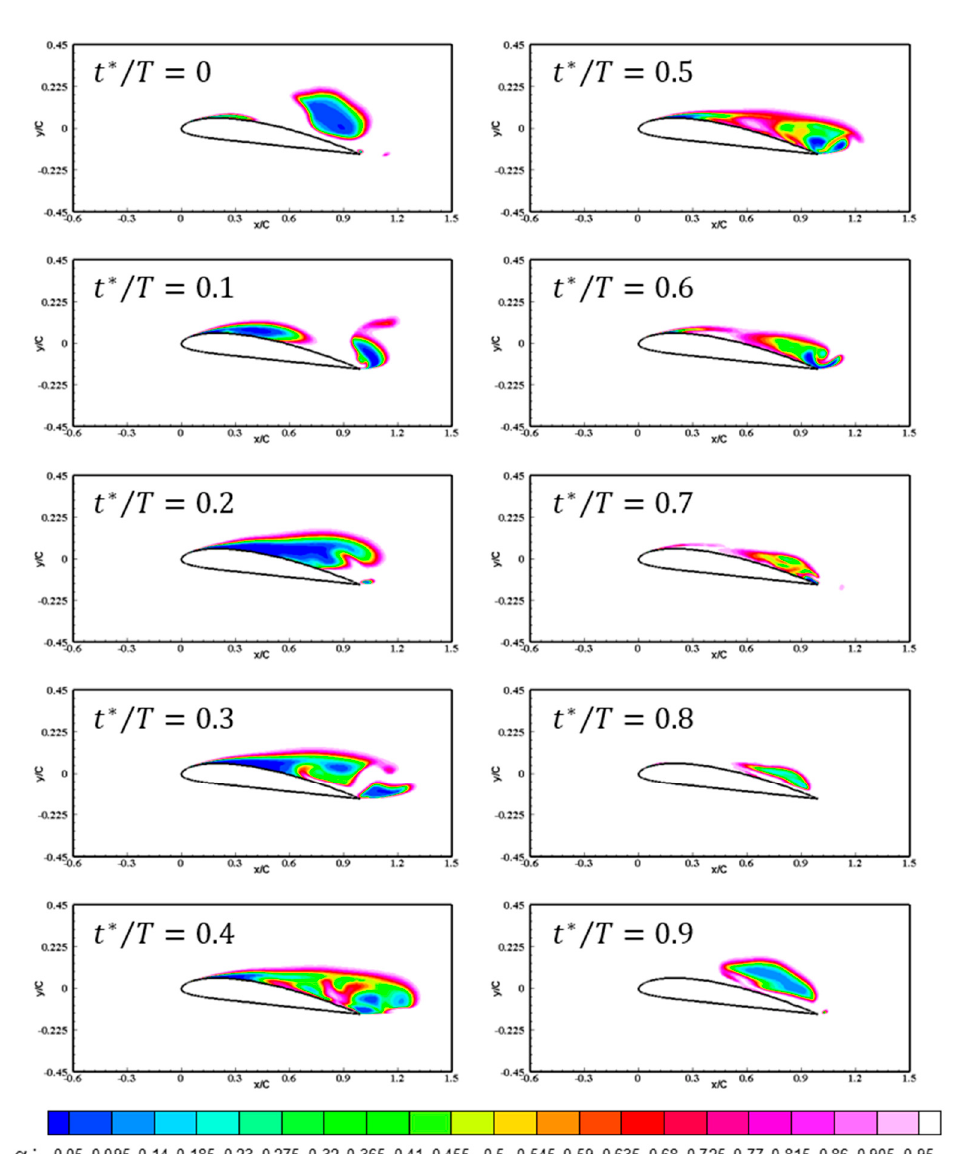
Figure 6. Time-variation of predicted liquid volume fraction in viscous lagging case.